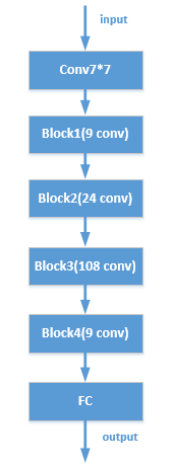
Figure 8. Modified